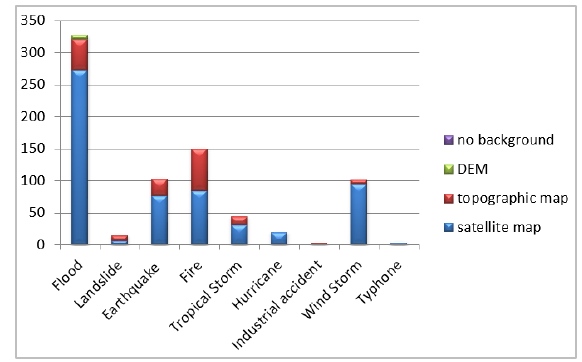
Figure 3. The use of different map's background with respect to the type of